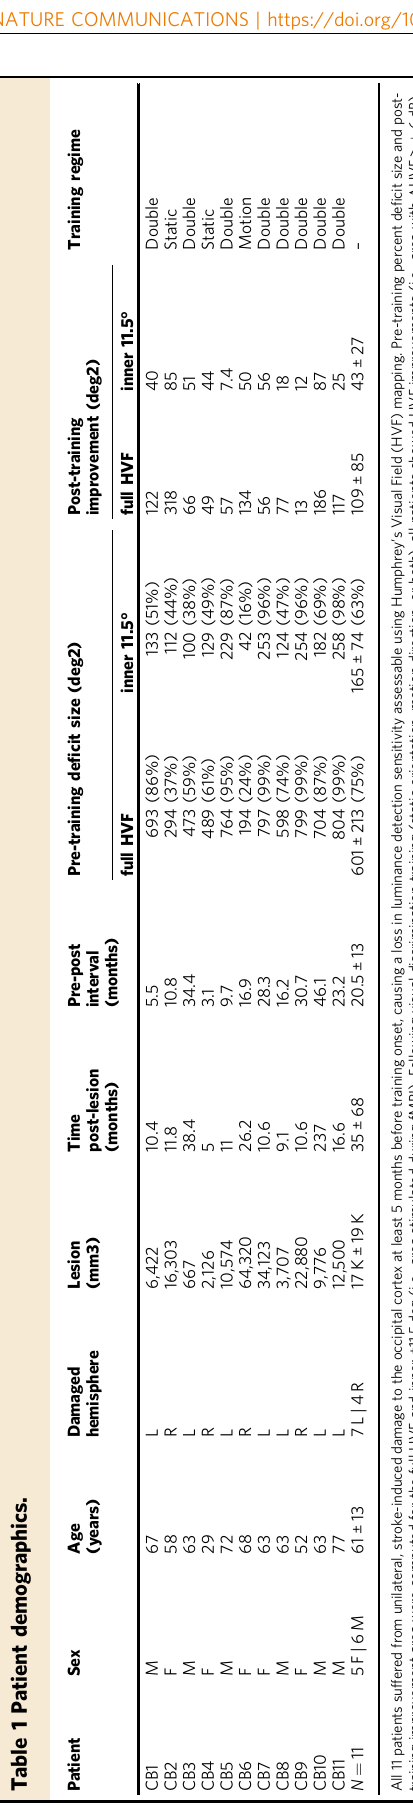
of assessing visual- fi eld defects. Before training, CB patients were unable to discriminate the orientation (accuracy: 55.2 ± 5.8%) or global motion direction (normalized thresholds: 86.2 ± 12.2%) of visual targets presented within their blind fi eld (Fig. 1). This was despite normal performance at corresponding locations within their intact fi eld (intact pre vs blind pre ; orientation discrimination: t(9) = 27.44, p < 0.001, d = 8.68, Fig. 1c; motion thresholds: t(8) = 20.67, p < 0.001, d = 6.89, Fig. 1d). Following training, performance improved at trained locations (blind pre vs blind post ; orientation discrimination: t(9) = 15.9, p < 0.001, d = 5.03, Fig. 1c; motion thresholds: t(8) = 16.00, p < 0.001, d = 5.33, Fig. 1d), reaching levels not signi fi cantly different from those at intact- fi eld locations (intact post vs blind post ; orientation dis- crimination: t(9) = 1.64, p = 0.135, d = 0.52, Fig. 1c; motion thresholds: t(8) = 1.28, p = 0.235, d = 0.43, Fig. 1d). Thus, chronic CB patients were able to relearn discrimination of stimuli not optimal for blindsight with intensive, visual discrimination training.